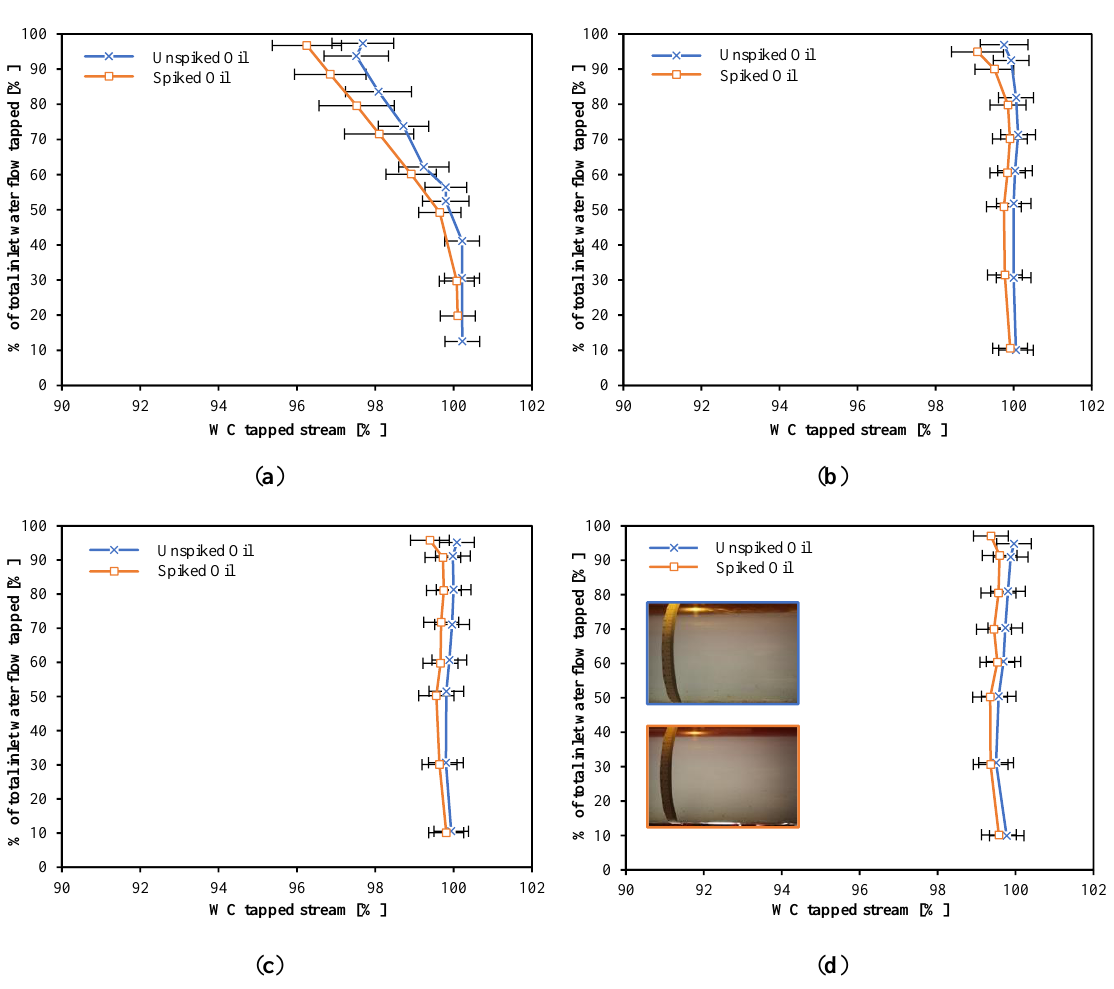
Figure 9. Drainage potential for spiked oil and water and unspiked oil and water with total flow rate of 300 L/min, at WC inlet ( a ) 30%, ( b ) 50%, ( c ) 70%, and ( d ) 90%.